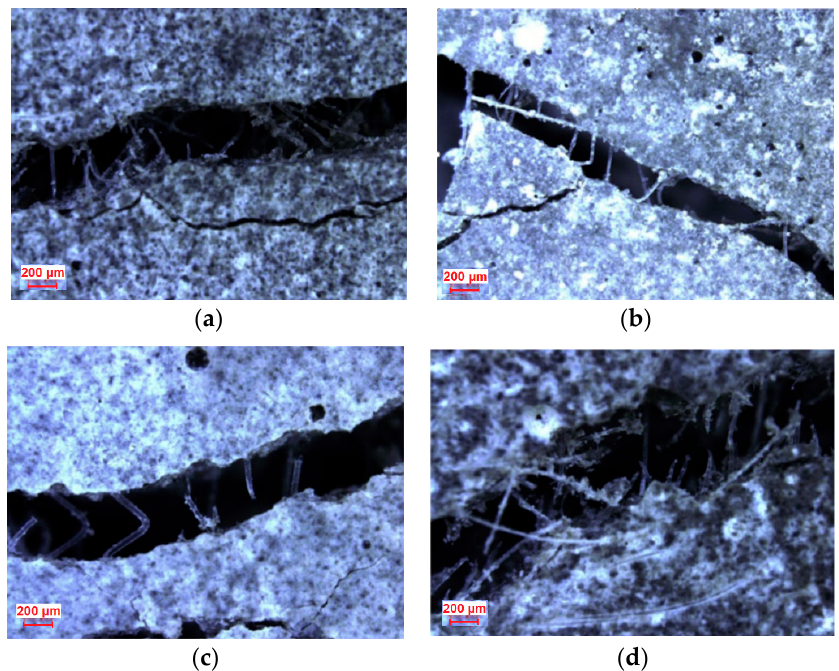
Figure 13. Microscopic images of cracked beams with different fiber lengths and volume fractions, including bridging fibers [73]. ( a ) PVA length of 8 mm and fiber content of 1%, ( b ) PVA length of 12 mm and fiber content of 1%, ( c ) PVA length of 8 mm and fiber content of 2%, and ( d ) PVA length of 12 mm and fiber content of 2%.